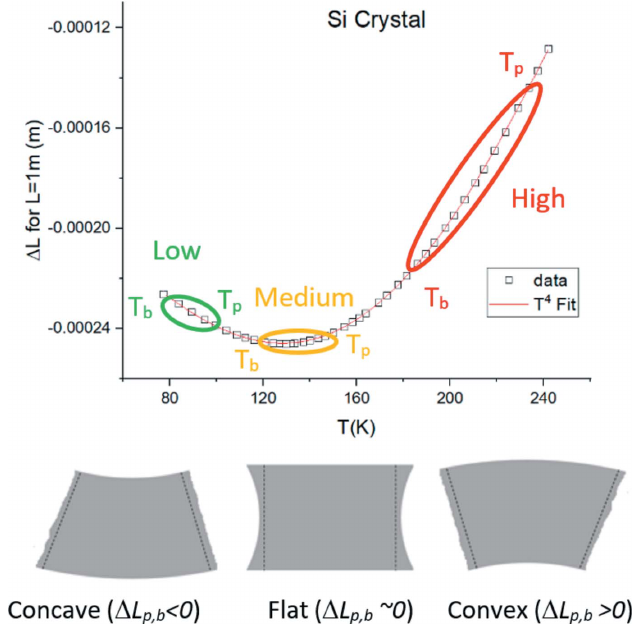
Figure 4 Top: length expansion of Si (squares) fitted by a T 4 polynomial (red line). The ellipses show the location of T p and T b on the graph for three different regions of low, medium and high power. Bottom: schematic shape of the crystal deformation from the concave to convex regime for the three power